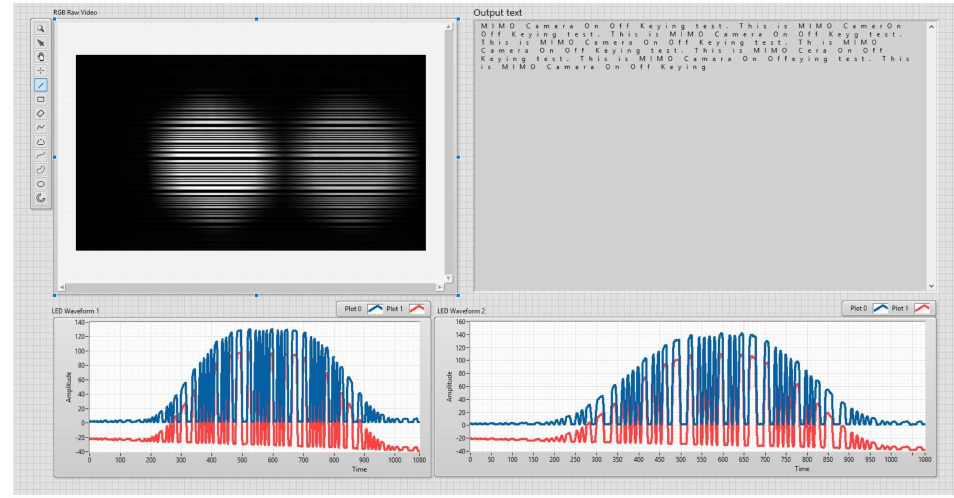
Figure 15. Setup for the MIMO–COOK implementation.